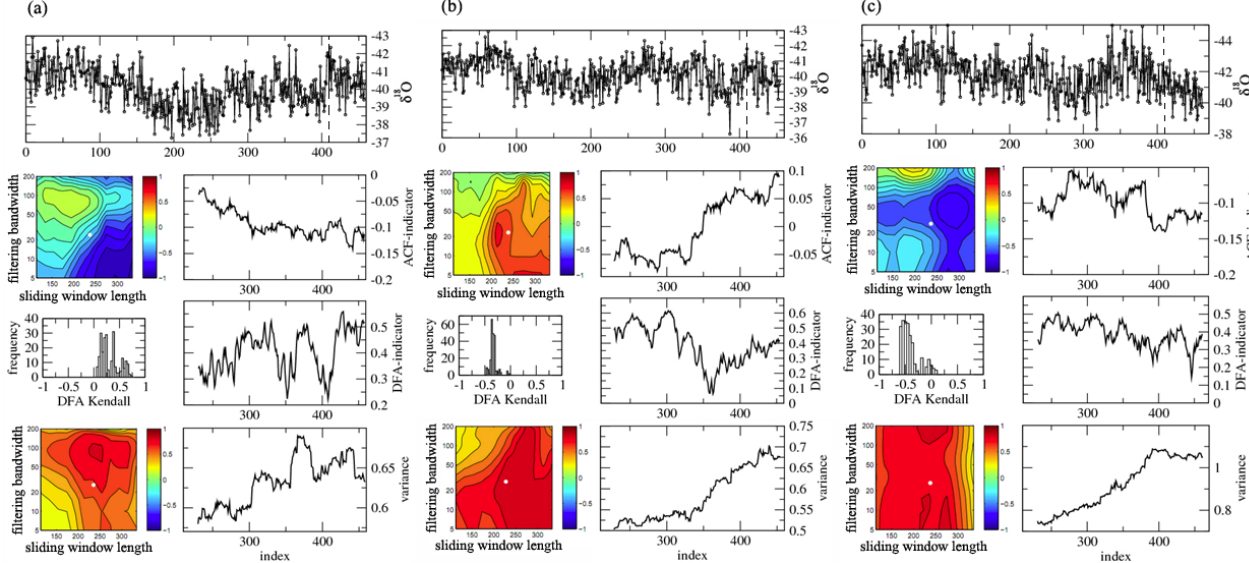
Fig. 7. Indicators of slowing down and changing variance of the stadial climate state, joining Greenland ice-core δ 18 O paleo-temperature proxy records of the run-up to the Bølling warming to the Younger Dryas: (a) GRIP (b) GISP2 (c) NGRIP. Here the data 22.88–14.76ka are spliced to 12.68–11.74ka ( n =455) at the point indicated by the vertical dashed line, and the resulting time series is just given an index value (point number). Otherwise panel descriptions are as in Fig. 3.